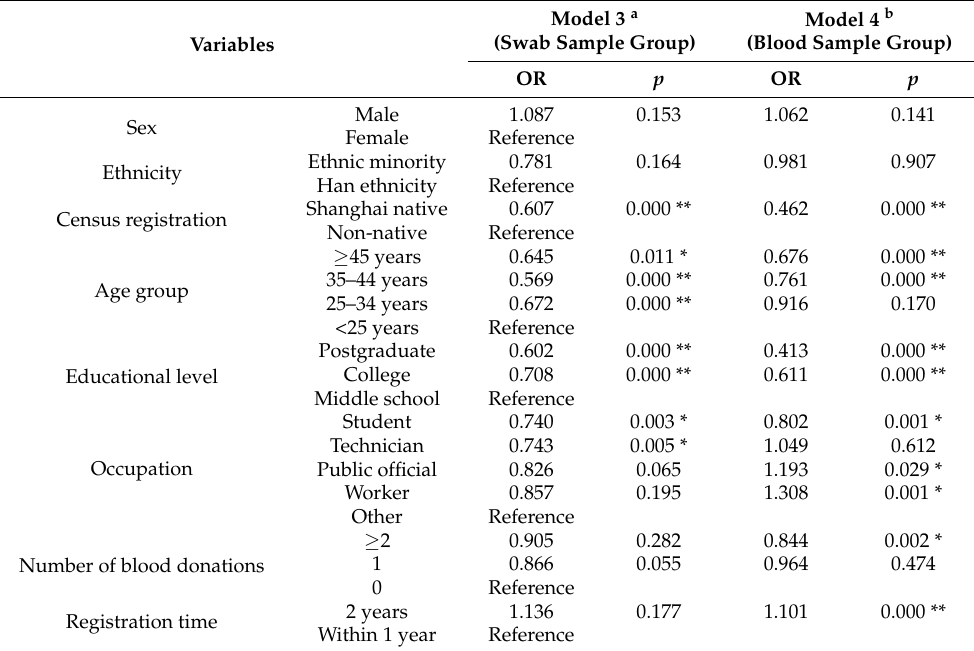
Table 3. Multiple logistic regression model of volunteer retention according to sampling